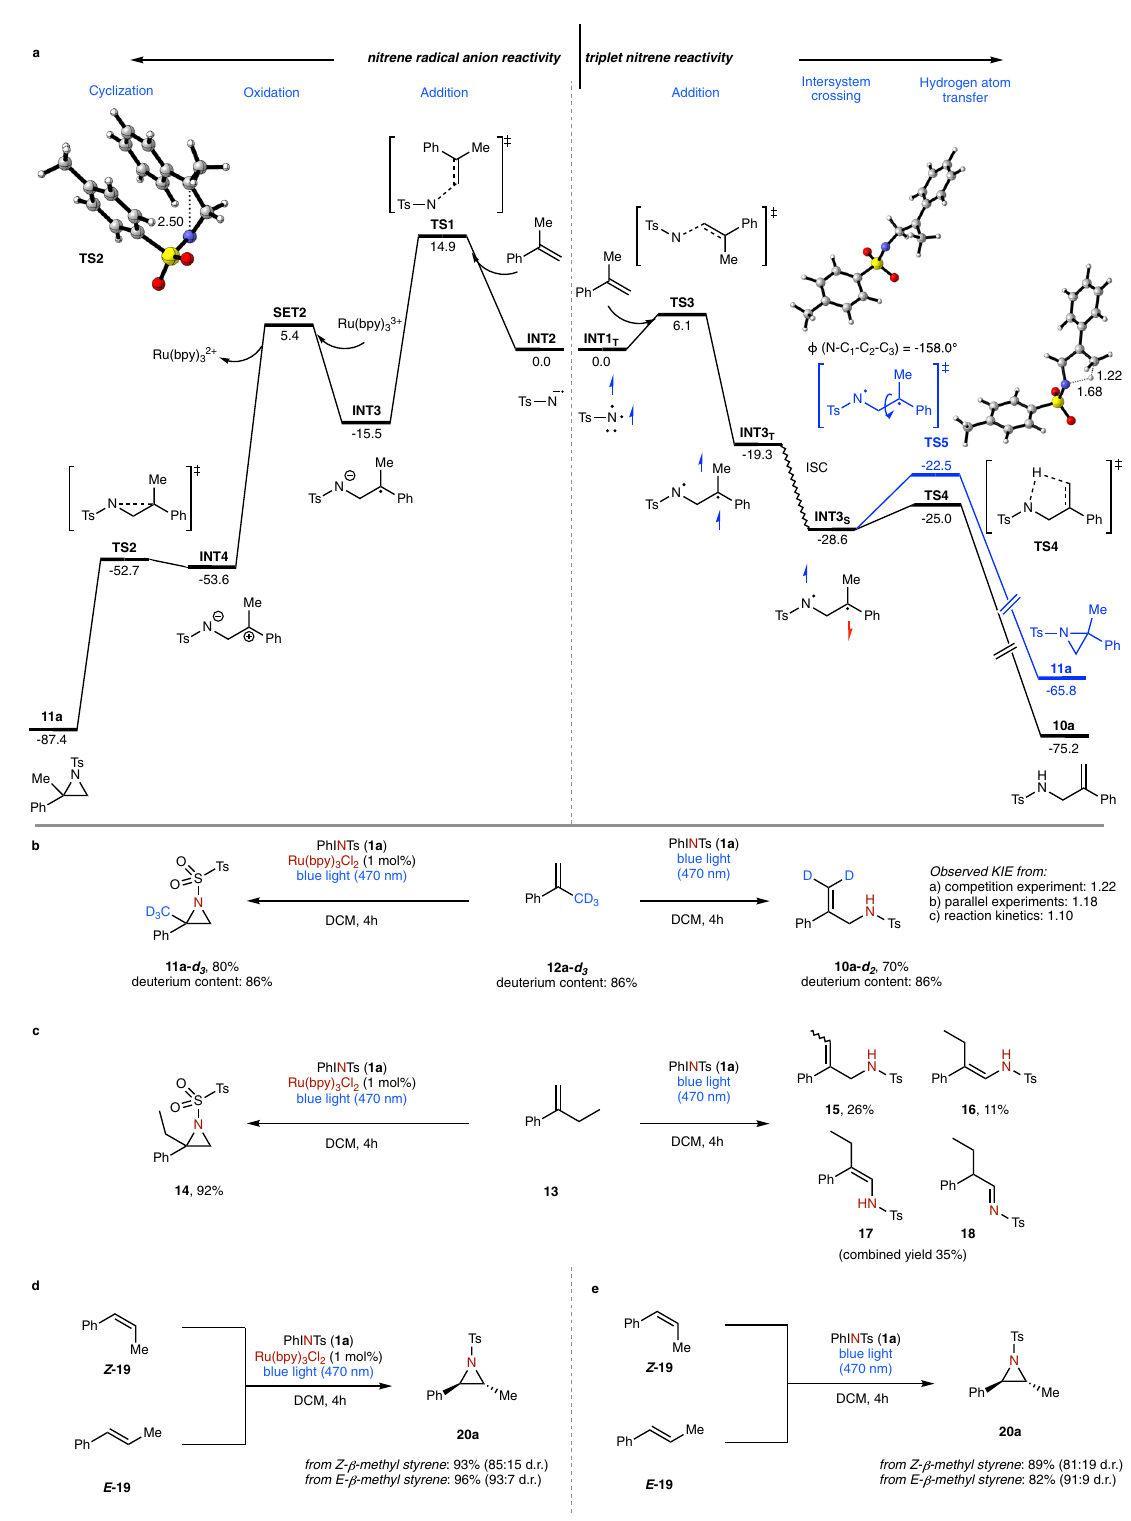
Fig. 4 Control experiments and theoretical calculations on the formation of the nitrene intermediate; calculations were performed at the SMD(DCM)- (U)M06-2X-D3/def2-TZVP//(U)M06-2X-D3/def2-SVP level of theory. a Energy surface of the reaction of triplet nitrene and nitrene radical anion. Gibbs energies are given in kcal mol − 1 . b Reaction with deuterated α -methyl styrene. c Reaction with α -ethyl styrene. d Photocatalytic reaction with β -methyl styrene. e Photochemical reaction with β -methyl